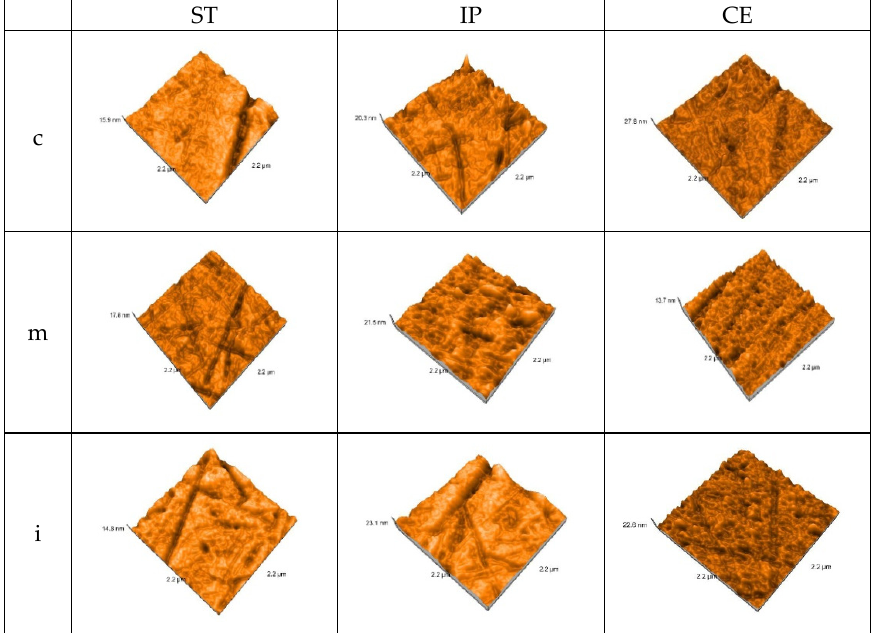
Figure 5. 3D AFM images of the glazed samples, after aging.ST = STML, IP = IPS e.maxZirCAD CEREC/in Lab MT Multi, CE = CeramillZolidfx ML c = cervical, m = medium, i = incisal. After autoclaving, the AFM 3D images on each area for polished samples are represented in Figure 6.